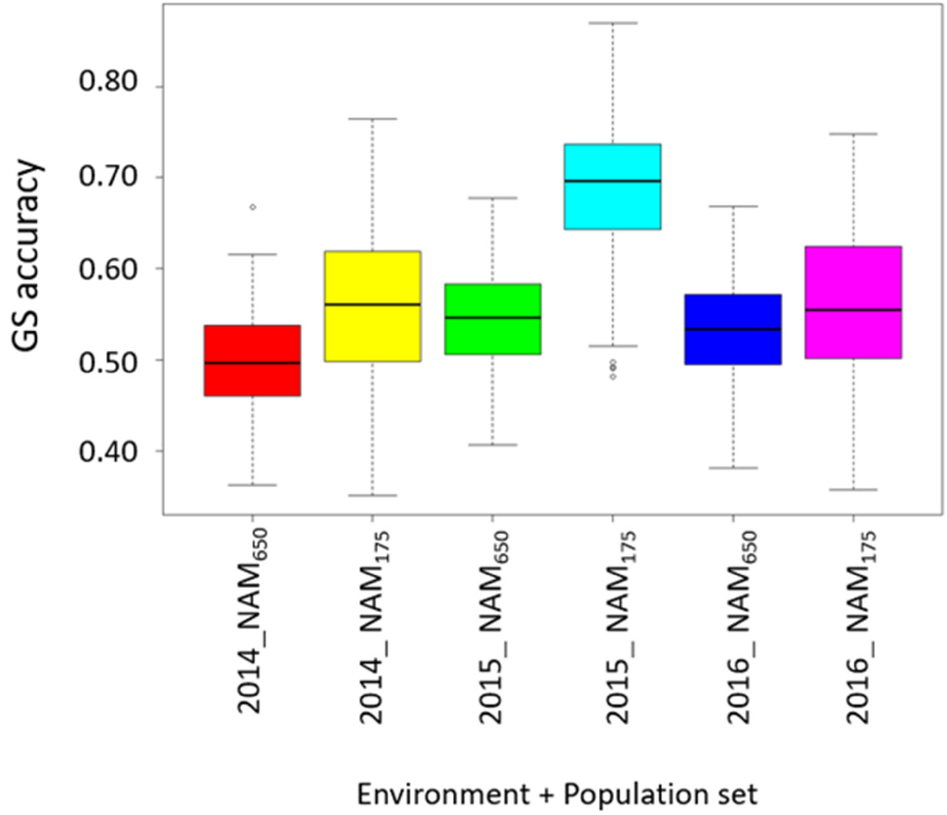
Figure 4. Comparison of GS prediction accuracies for the NAM 650 and NAM 175 populations for GPC. The X-axis represents the combination of population and environment, and the Y-axis represents the prediction accuracies.